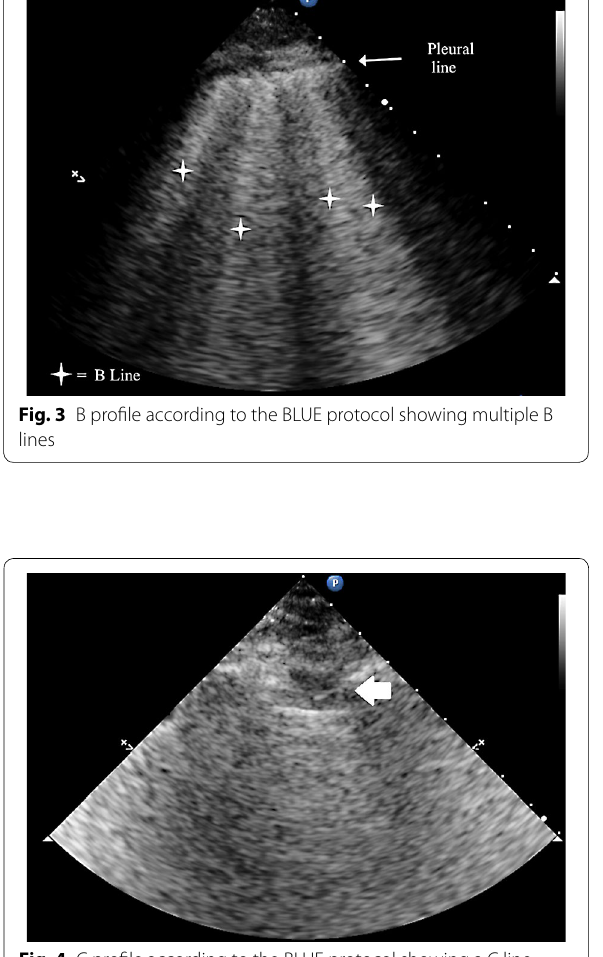
Fig. 4 C profile according to the BLUE protocol showing a C line. Arrow indicates a hypoechoic subpleural focal image generated by consolidated lung tissue